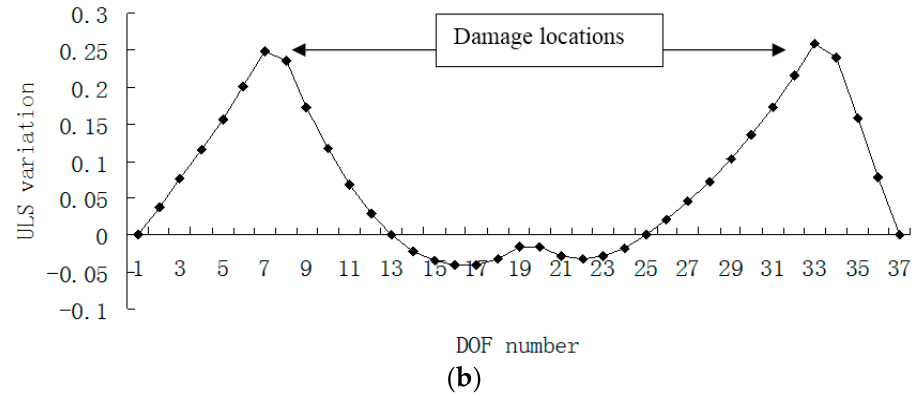
Figure 15. ( a ) Damage index (PE) map using the first four exact modes when the defects occurred in elements 7, 19 and 33; ( b ) Damage index (ULS variation) map using the first four exact modes when the defects occurred in elements 7, 19 and 33 (×10 − 4 ).